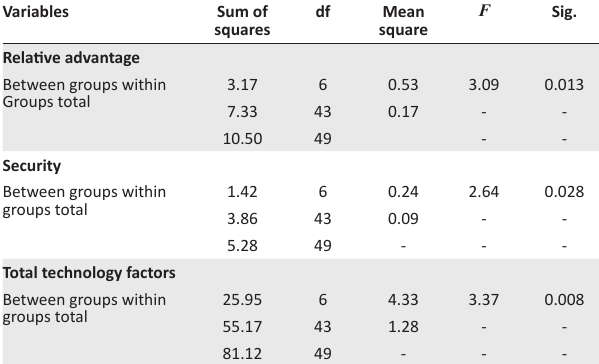
TABLE 2: Analysis of variance technology factors by year.